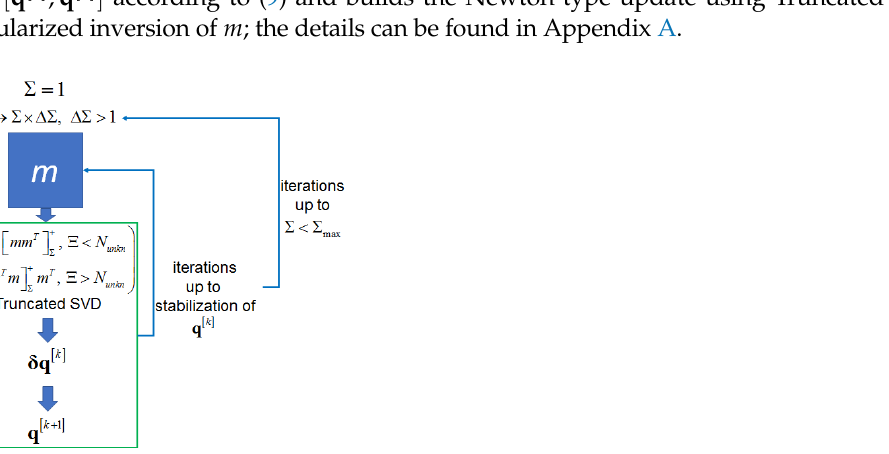
Figure 1. The principal scheme on the algorithm’s iterations (the outer and the middle loops), the inner loop is inside the green box. The most time-consuming part of the algorithm (more than 95% of all computations) is constructing the sensitivity operator’s matrix m